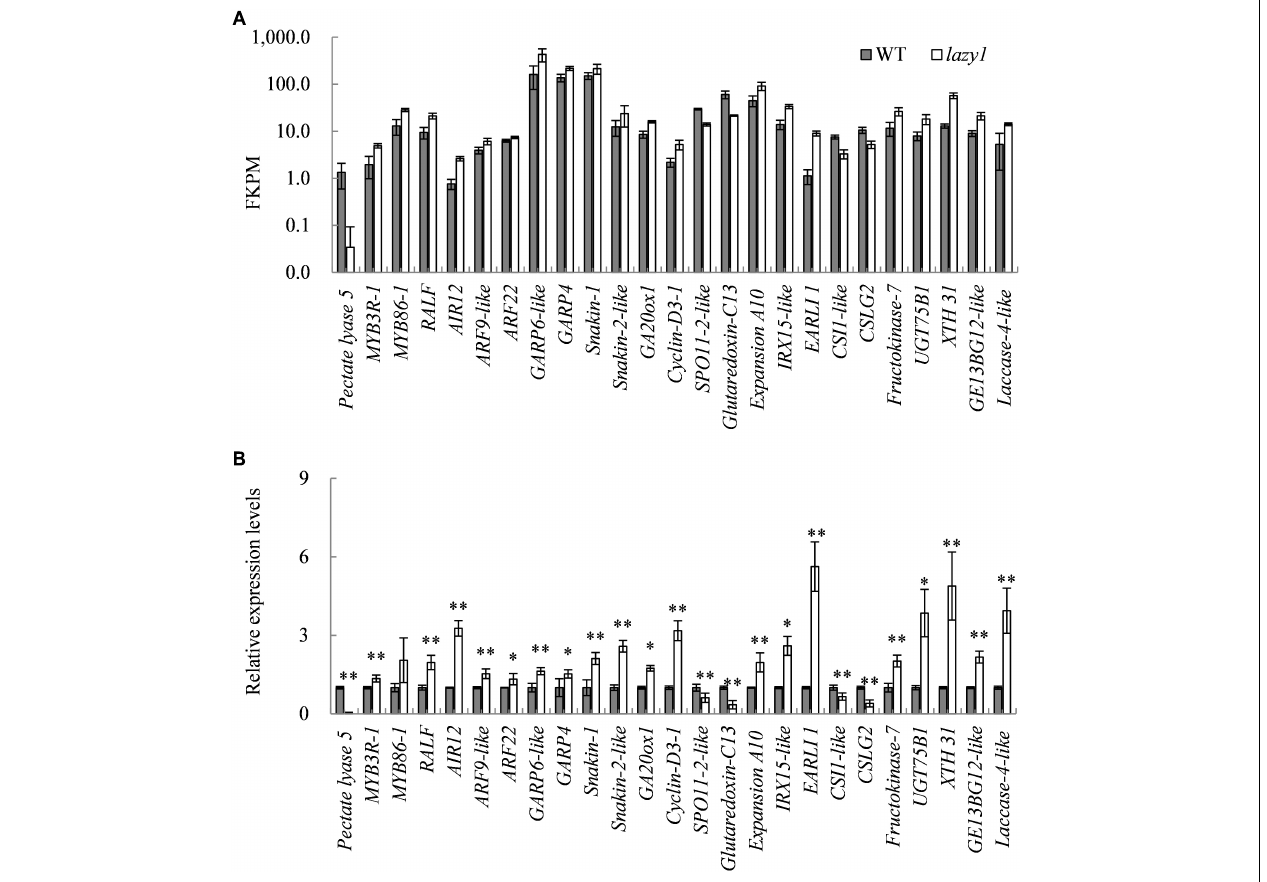
FIGURE 6 | Quantitative real-time PCR analysis of DEGs related to lazy1 phenotype. (A) The FKPM value of genes by RNA-seq. (B) The relative expression levels of gene by qRT-PCR. Bars indicate standard deviation (SD, n = 4). ∗ and ∗∗ indicate the significant difference at 0.05 and 0.01 levels, respectively between WT and